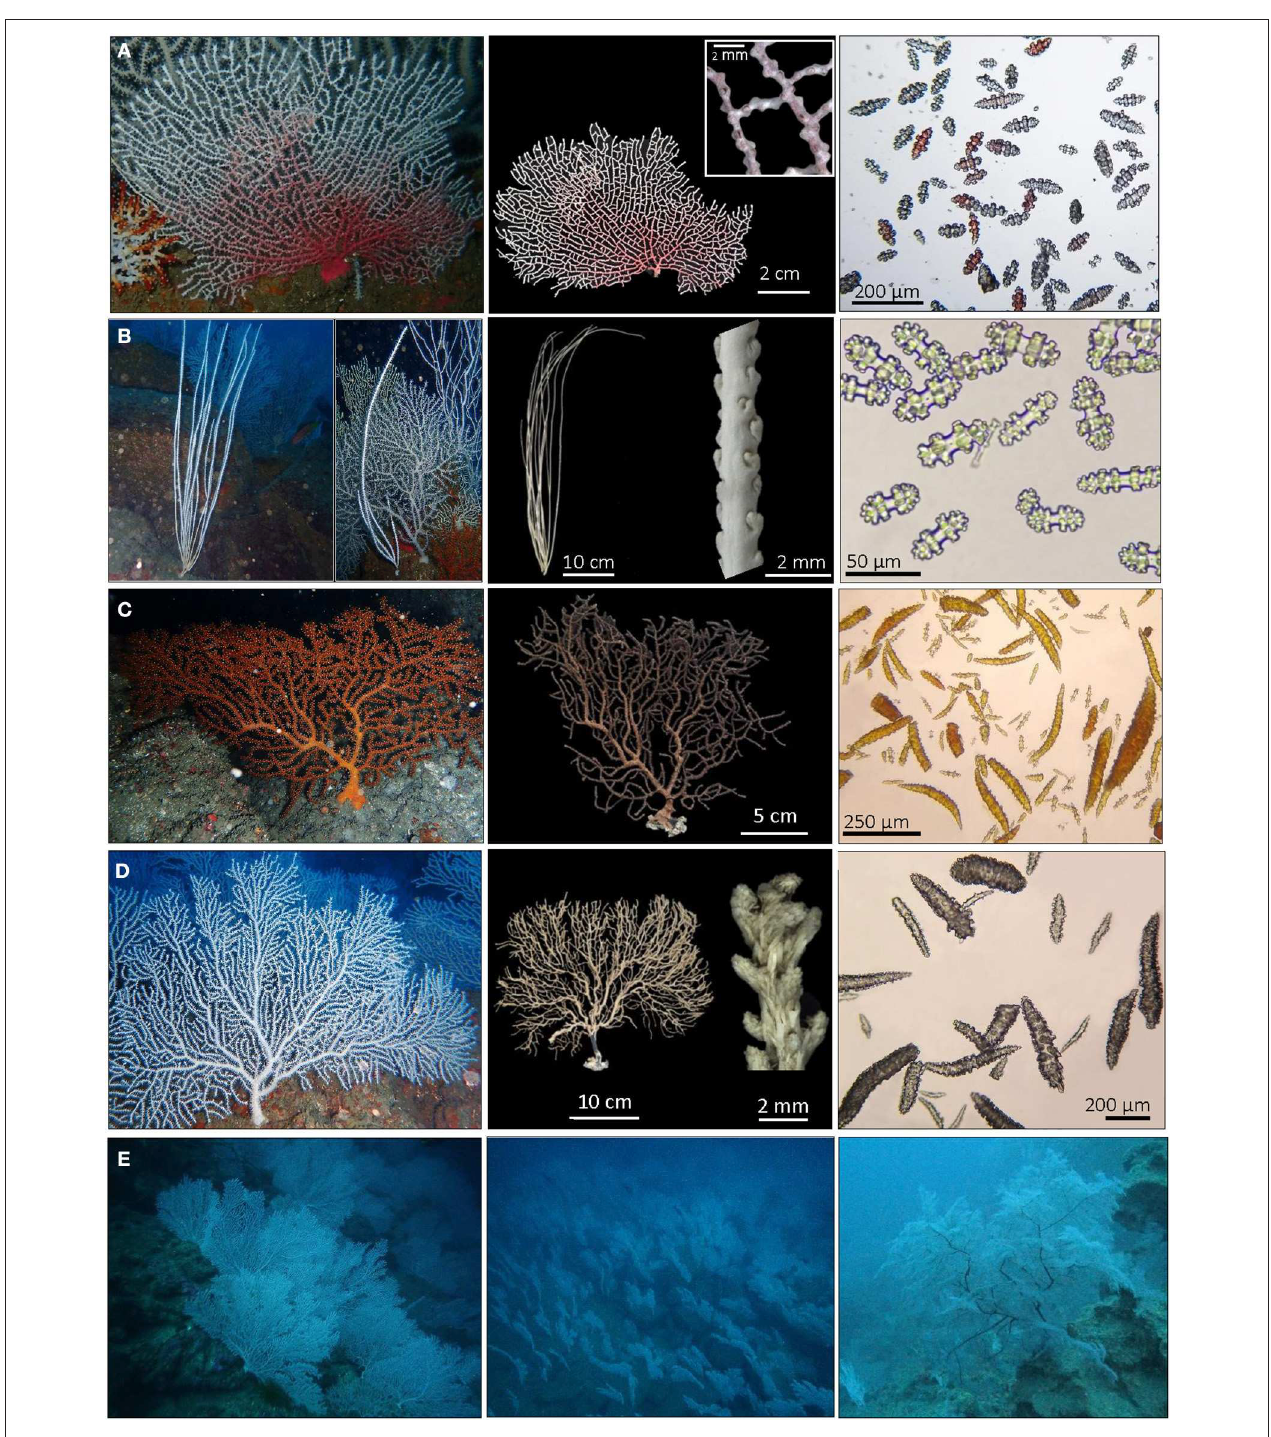
FIGURE 2 | Mesophotic octocoral and black coral communities in northern Chocó, Colombian Pacific, with photographs in situ (left), dry preserved (center), and sclerites (right). (A) Pacifigorgia senta . (B) Ellisella limbaughi . (C) Muricea plantaginea . (D) Muricea subtilis . (E) Whitish mesophotic octocorals community and one colony of the black coral Myriopathes panamensis